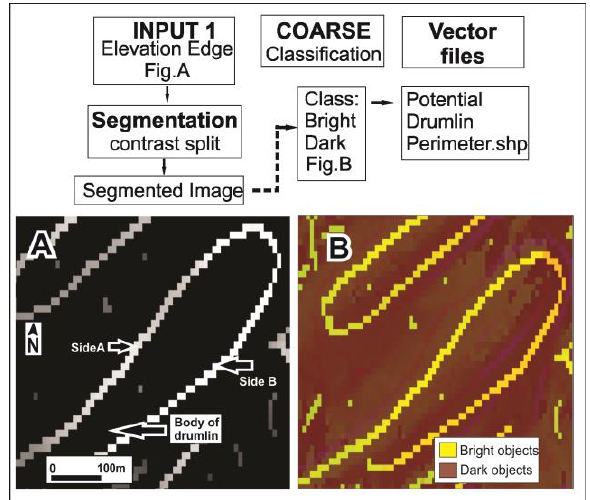
Figure 7. Pre-processing of data for automated extraction of submarine drumlins: A. Application of Canny Edge Detector filter to a layer with very high pixel values where there was an edge between two objects, B. classified image with Potential Drumlin Perimeter